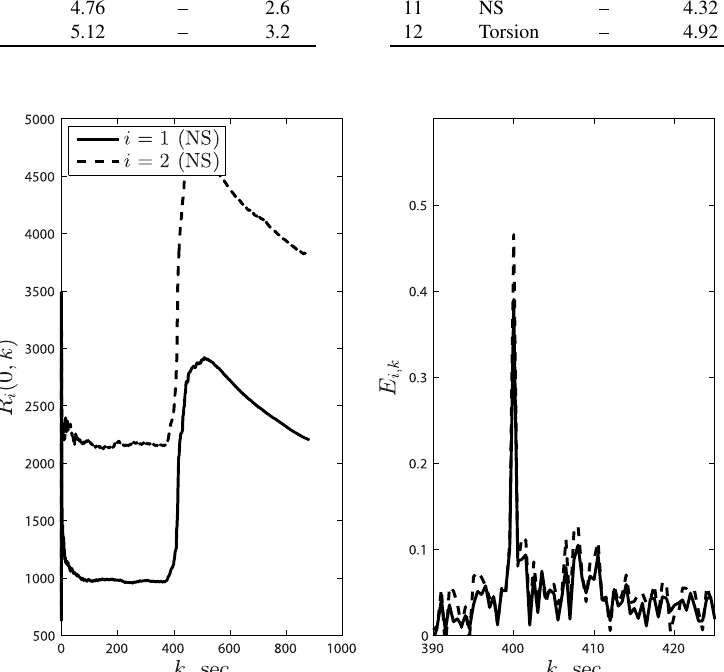
Fig. 14. Time-dependent variance and damage index of the typical floor response in NS